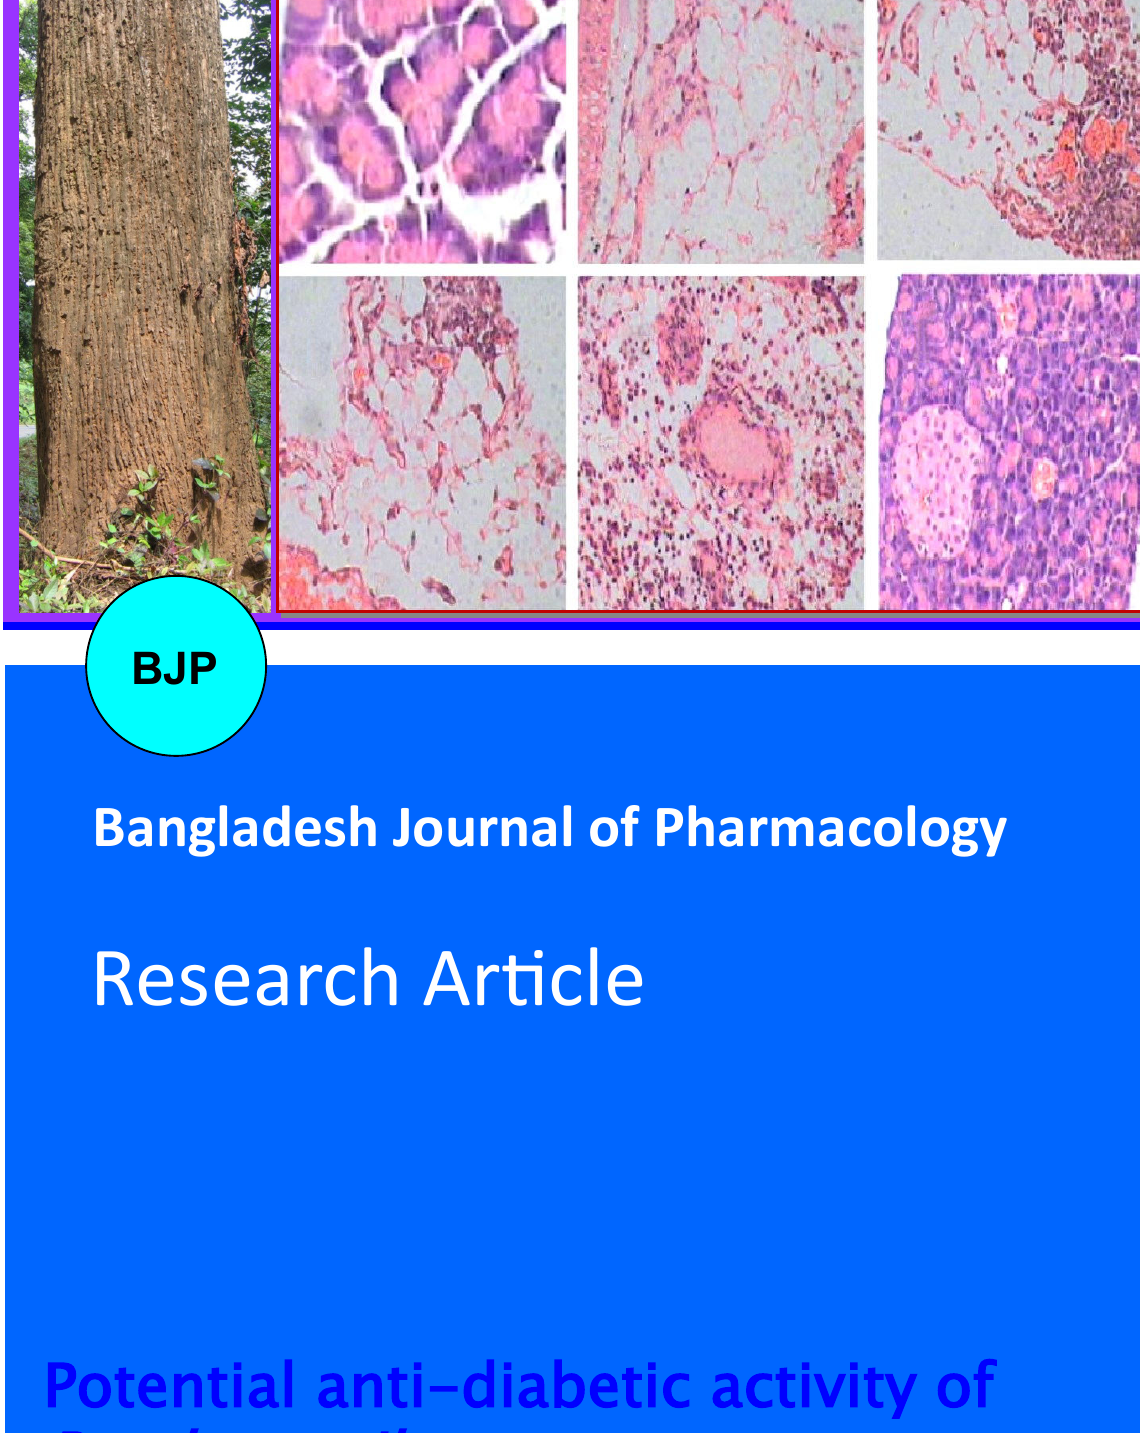
Potential anti-diabetic activity of Bombax ceiba